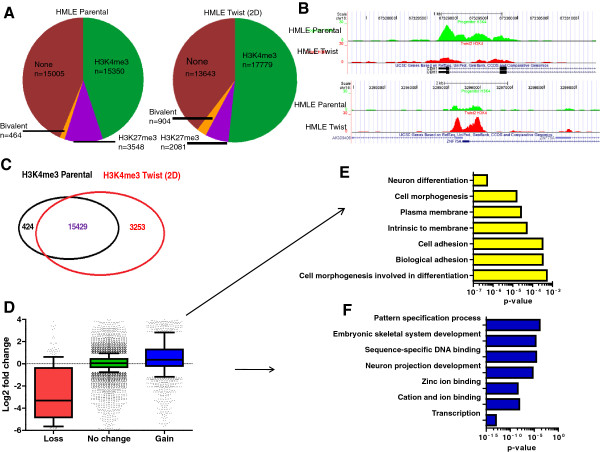
H3K4me3 dynamic modifications are coupled with transcriptional changes related to epithelial-mesenchymal transition genes. (A) Pie chart showing the distribution of H3K4me3 and H3K27me3 marks in human mammary epithelial cells (HMLE) vector cells and HMLE Twist cells. (B) Landscape of H3K4me3 for CDH1 (loss of H3K4me3 in vector cells) and ZNF75A (gain of H3K4me3) in HMLE Twist cells. (C) Venn diagram of H3K4me3 at gene promoters in HMLE vector cells and HMLE Twist cells. (D) Box plots for gene expression changes in genes losing or gaining the H3K4me3 mark. (E) Gene ontology analysis using DAVID for genes losing the H3K4me3 mark. The x-axis represents the P-value levels and y-axis the gene ontology pathways. (F) Gene ontology analysis using DAVID for genes gaining the H3K4me3 mark. The x-axis represents the P-value levels and y-axis the gene ontology pathways.